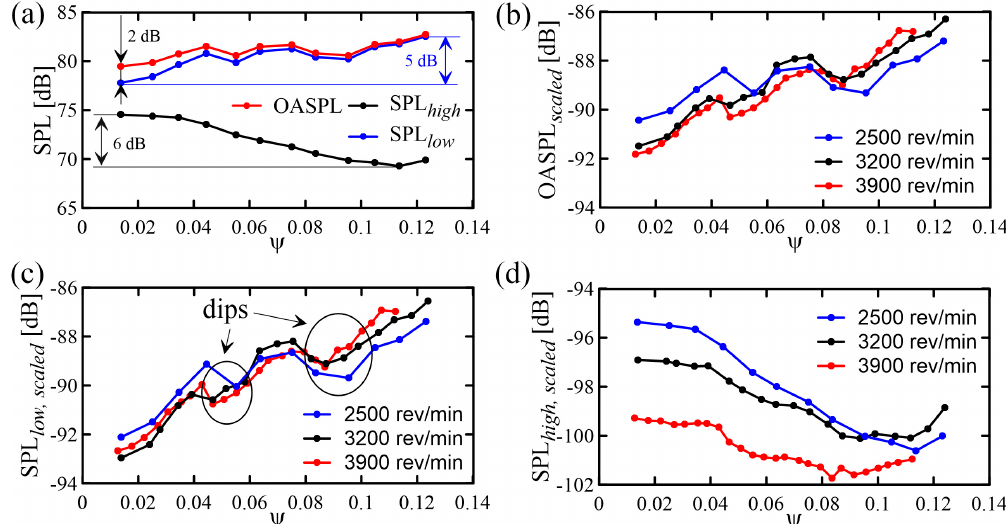
Figure 6. SPL in different frequency ranges. ( a ) SPL low , SPL high and overall sound pressure level (OASPL) at Ω = 3200 rev/min; ( b ) OASPL scaled at Ω = 2500, 3200 and 3900 rev/min; ( c ) SPL low,scaled at Ω = 2500, 3200 and 3900 rev/min; ( d ) SPL high,scaled at Ω = 2500, 3200 and 3900 rev/min.